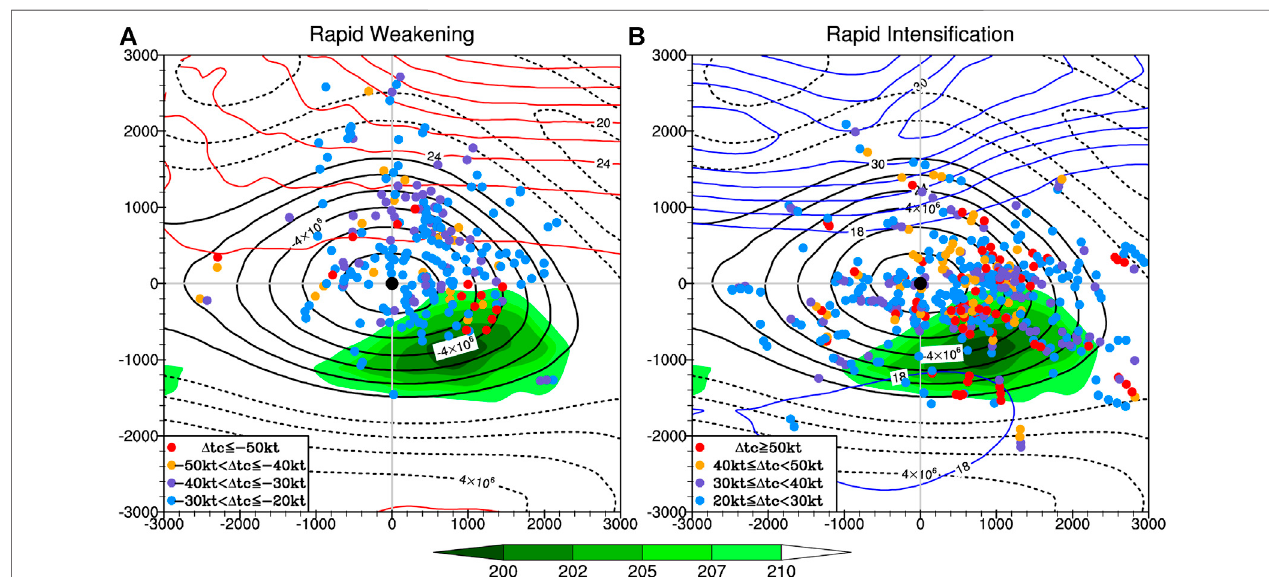
FIGURE9| Thepositionsof (A) RWand (B) RIevents(color dots) withrespecttotheMGcenter(largeblack dot).Thered contours in (A) areSST( ° C)and theblue contours in (B) are VWS between 200 and 850 hPa (m s − 1 ) in the composite MG, respectively. The black contours and shadings in (A) and (B) are the streamfunction (m 2 s − 1 ) and the distribution of OLR (K) in the composite MG, respectively.